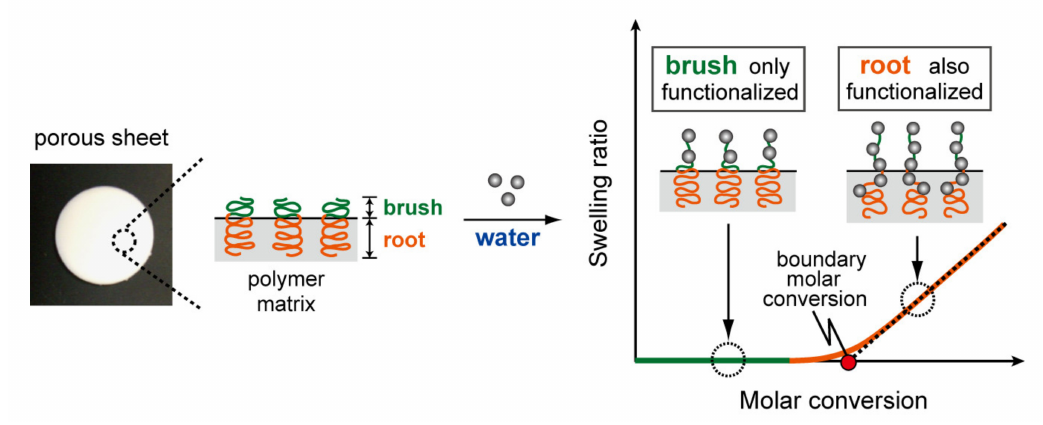
Figure 2. Schematics of determination method for mole percentage of the polymer brush and